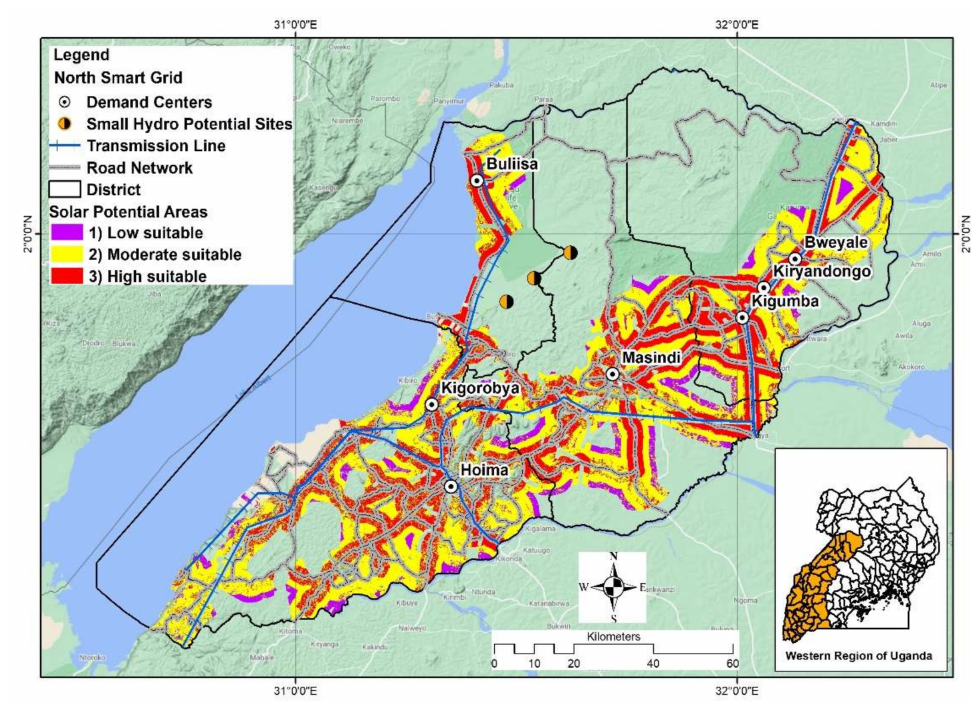
Figure 18. Final map of North smart grid suitability area.